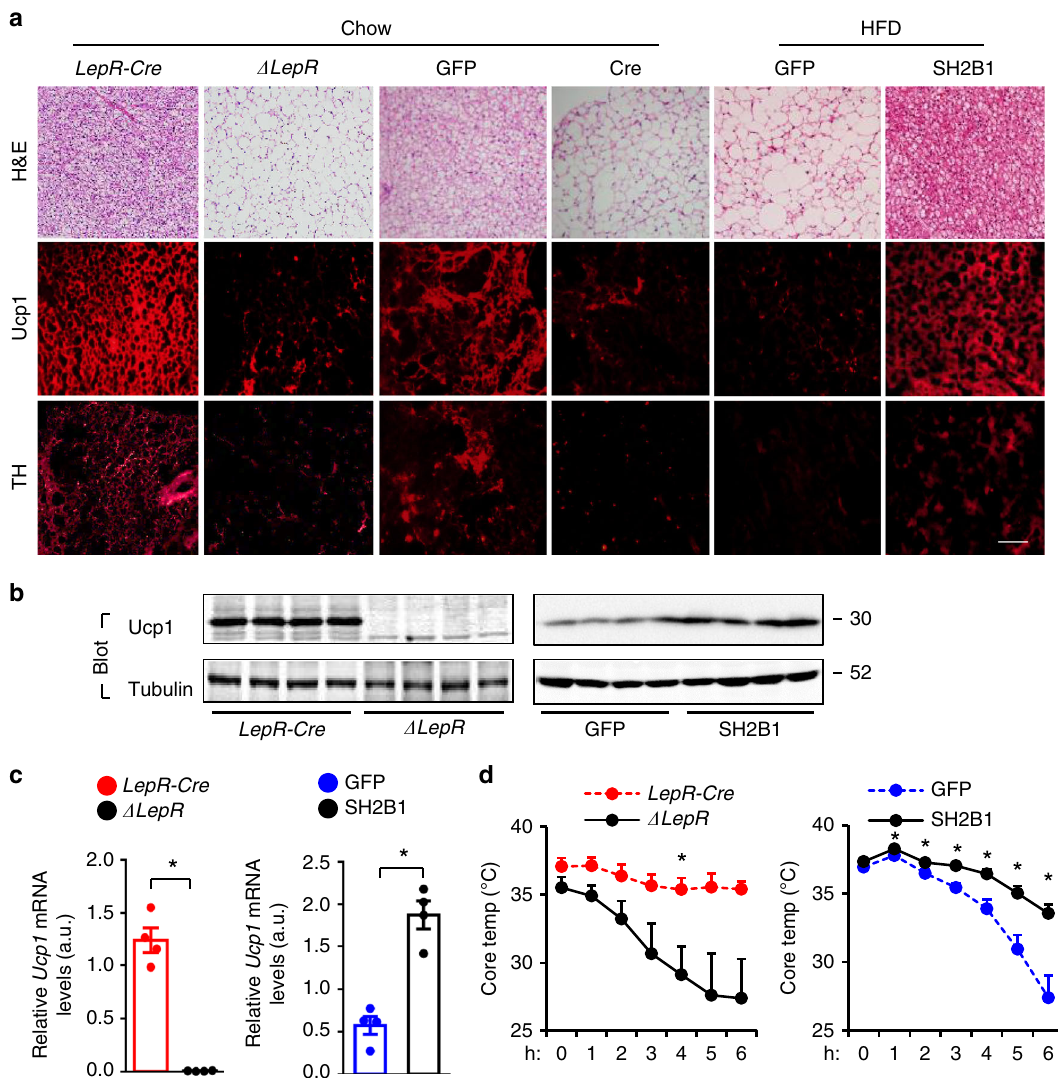
Fig. 5 Sh2b1 in LepR neurons supports the maintenance and function of BAT. a – c BAT was harvested from Sh2b1 Δ LepR and LepR-Cre males at 10 weeks of age, and from Sh2b1 f/f males in 11 weeks after they were bilaterally injected into the MBH with AAV1-hSyn-Cre or AAV1-hSyn-GFP vectors (on chow diet). Adult C57BL/6J males were bilaterally injected into the MBH with AAV9-CAG-SH2B1 β or AAV9-CAG-GFP vectors and then fed an HFD for 12 weeks. a Representative BAT images. Scale bar: 200 μ m. Sh2b1 Δ LepR : n = 3, LepR-Cre : n = 4, AAV1-hSyn-Cre: n = 7, AAV1-hSyn-GFP: n = 7, AAV9-CAG-GFP: n = 8, AAV9-CAG-SH2B1: n = 8. b BAT extracts were immunoblotted with the indicated antibodies. Sh2b1 Δ LepR : n = 4, LepR-Cre : n = 4, AAV9-CAG-GFP: n = 4, AAV9-CAG-SH2B1: n = 4. c Ucp1 mRNA levels were normalized to 36B4 levels. Sh2b1 Δ LepR : n = 4, LepR-Cre : n = 4, AAV9-CAG-GFP: n = 4, AAV9-CAG- SH2B1 β : n = 4. a.u. arbitrary units. d Core body temperature was recorded using E-Mitters in Sh2b1 Δ LepR ( n = 3) and LepR-Cre ( n = 3) at 10 weeks of age, on chow diet, and upon cold temperature (4 °C). Adult C57BL/6J males were bilaterally injected into the MBH with AAV9-CAG-GFP ( n = 7) or AAV9-CAG- SH2B1 β ( n = 7) vectors and then fed an HFD for 10 weeks. Rectal temperature was measured upon cold exposure. Data are presented as mean ± SEM. * p < 0.05, two-tailed unpaired Student ’ s t- test. Source data are provided as a Source Data fi